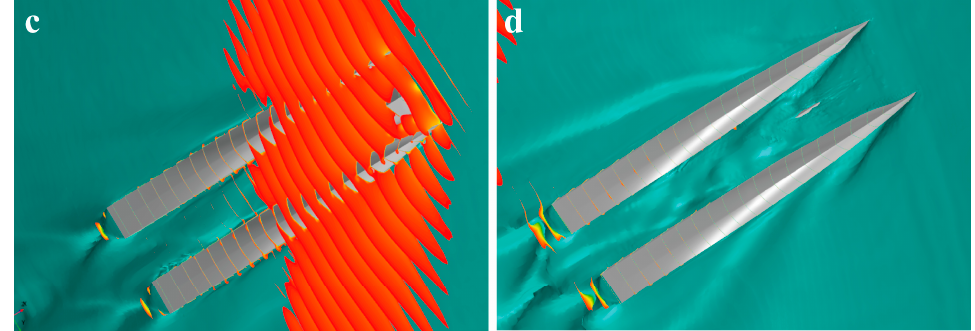
Figure 32. Boundary layer represented by slices colored with dimensionless axial velocity limited to Ux/U0 = 0.9 at 7 level sea state with the 30° wave direction. ( a ) T = 1/4 T 0; ( b ) T = 2/4 T 0; ( c ) T = 3/4 T 0; ( d ) T = 4/4 T 0.